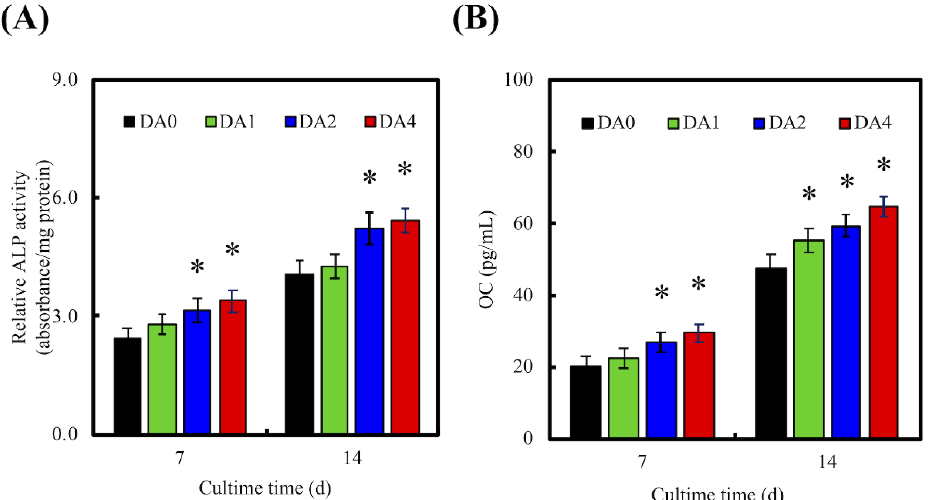
Figure 11. The protein expression of ( A ) ALP and ( B ) OC of WJMSC were cultured on PDA-coated CS cement for different days. “*” indicates a significant difference ( p < 0.05) compared to DA0.